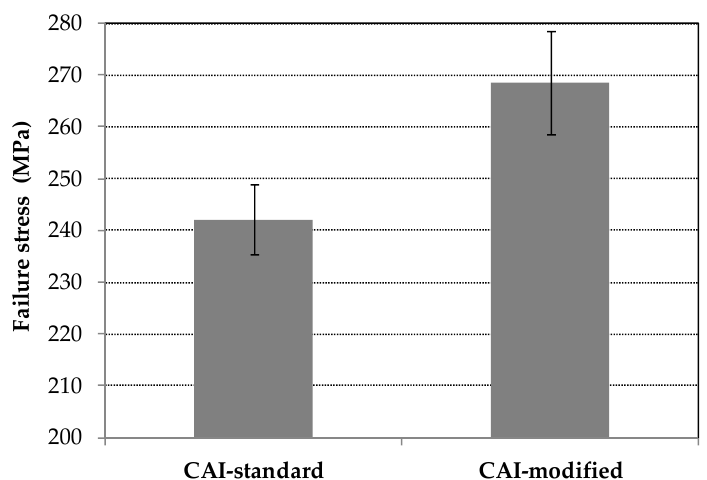
Figure 6. Failure stresses in CAI testing as well as the standard deviations for testing devices CAI-standard as well as CAI-modified.